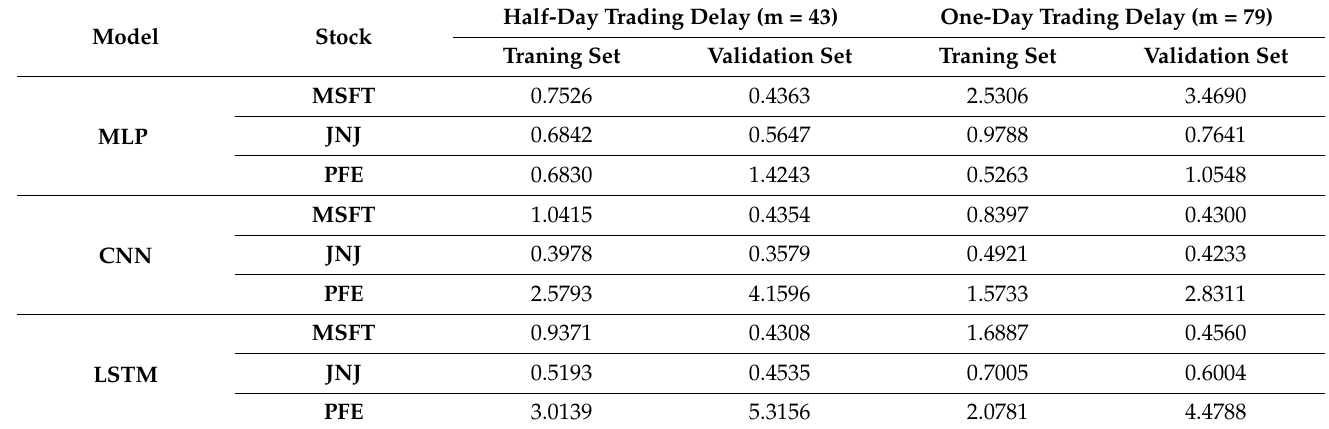
Table 5. The mean absolute percentage error of three deep learning